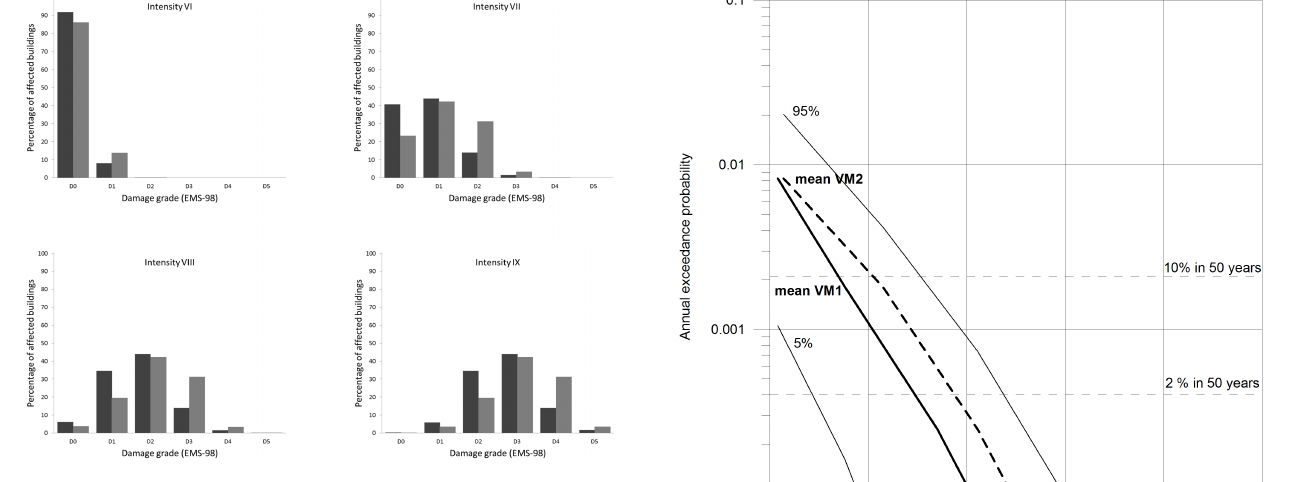
Figure 7. Structural damage distribution diagrams for the two vul- nerability models for different levels of EMS intensity (VM1 – dark grey, VM2 – light grey).